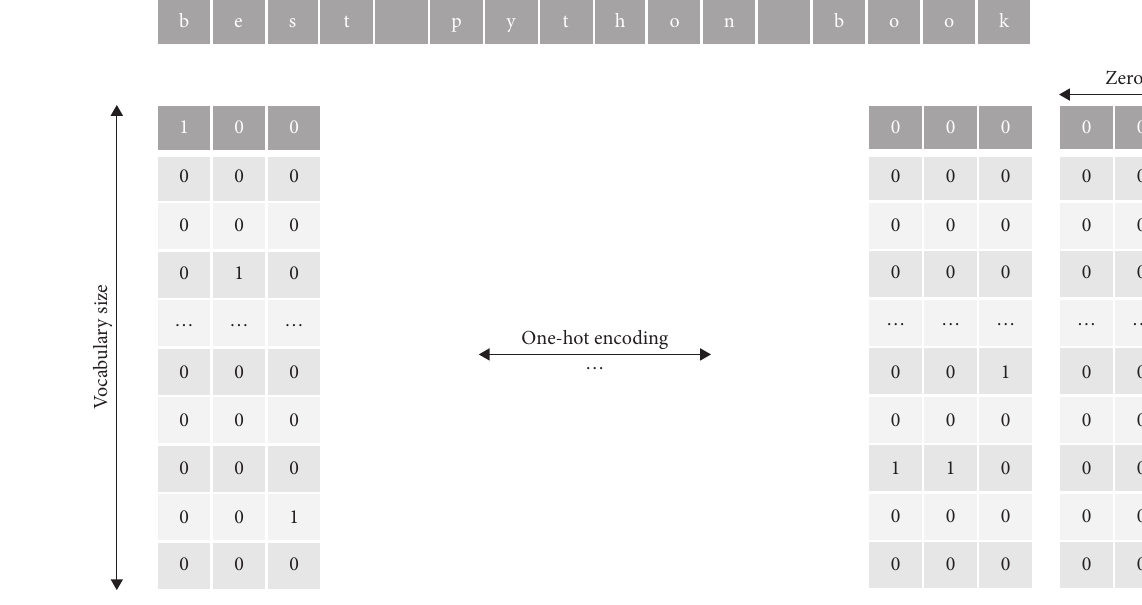
Figure 3: Character-level text